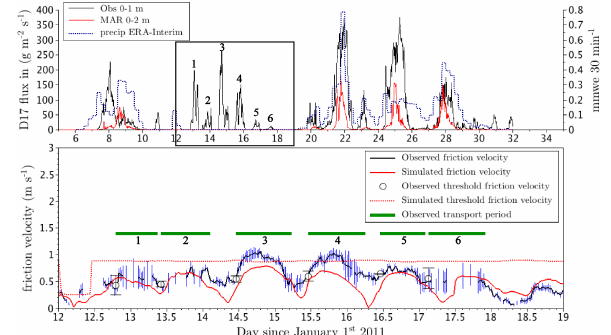
Figure 5. Observed (diamonds) and simulated (red squares) snow mass fluxes from 0 to 2m versus the observed (and simulated re- spectively) wind speed at 2m in January 2011 for the four strong aeolian snow transport events recorded at D47. Event 1 lasted from 7–10, event 2 from 21–22, event 3 from 24–26, and event 4 from 27–29 January. For the first event, the observed snow mass fluxes are decomposed in time between a first (blue), an intermediate (pur- ple), and a final relationship